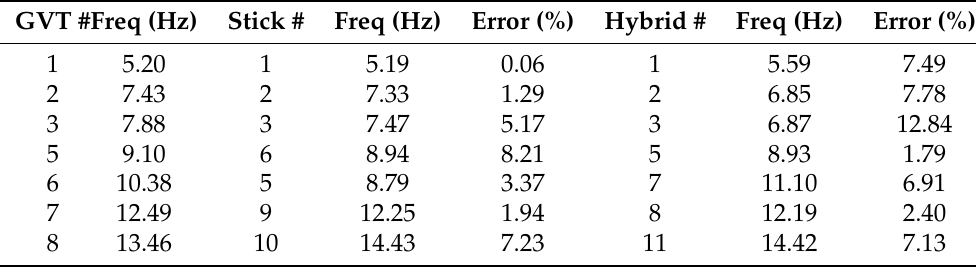
Table 6. Frequencies comparison between the experimental modes and corresponding numerical ones of the models developed before the optimization